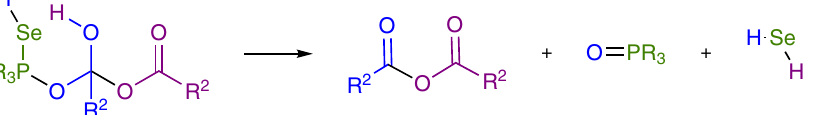
Fig. 3 Reaction scheme for H 2 Se release. a The proposed reaction scheme for the decomposition of tertiary phosphine selenide in the absence of Cd. b The steps of the proposed reaction mechanism with the tertiary phosphine in green and carboxylic acids in blue and purple. Newly formed bonds are in black